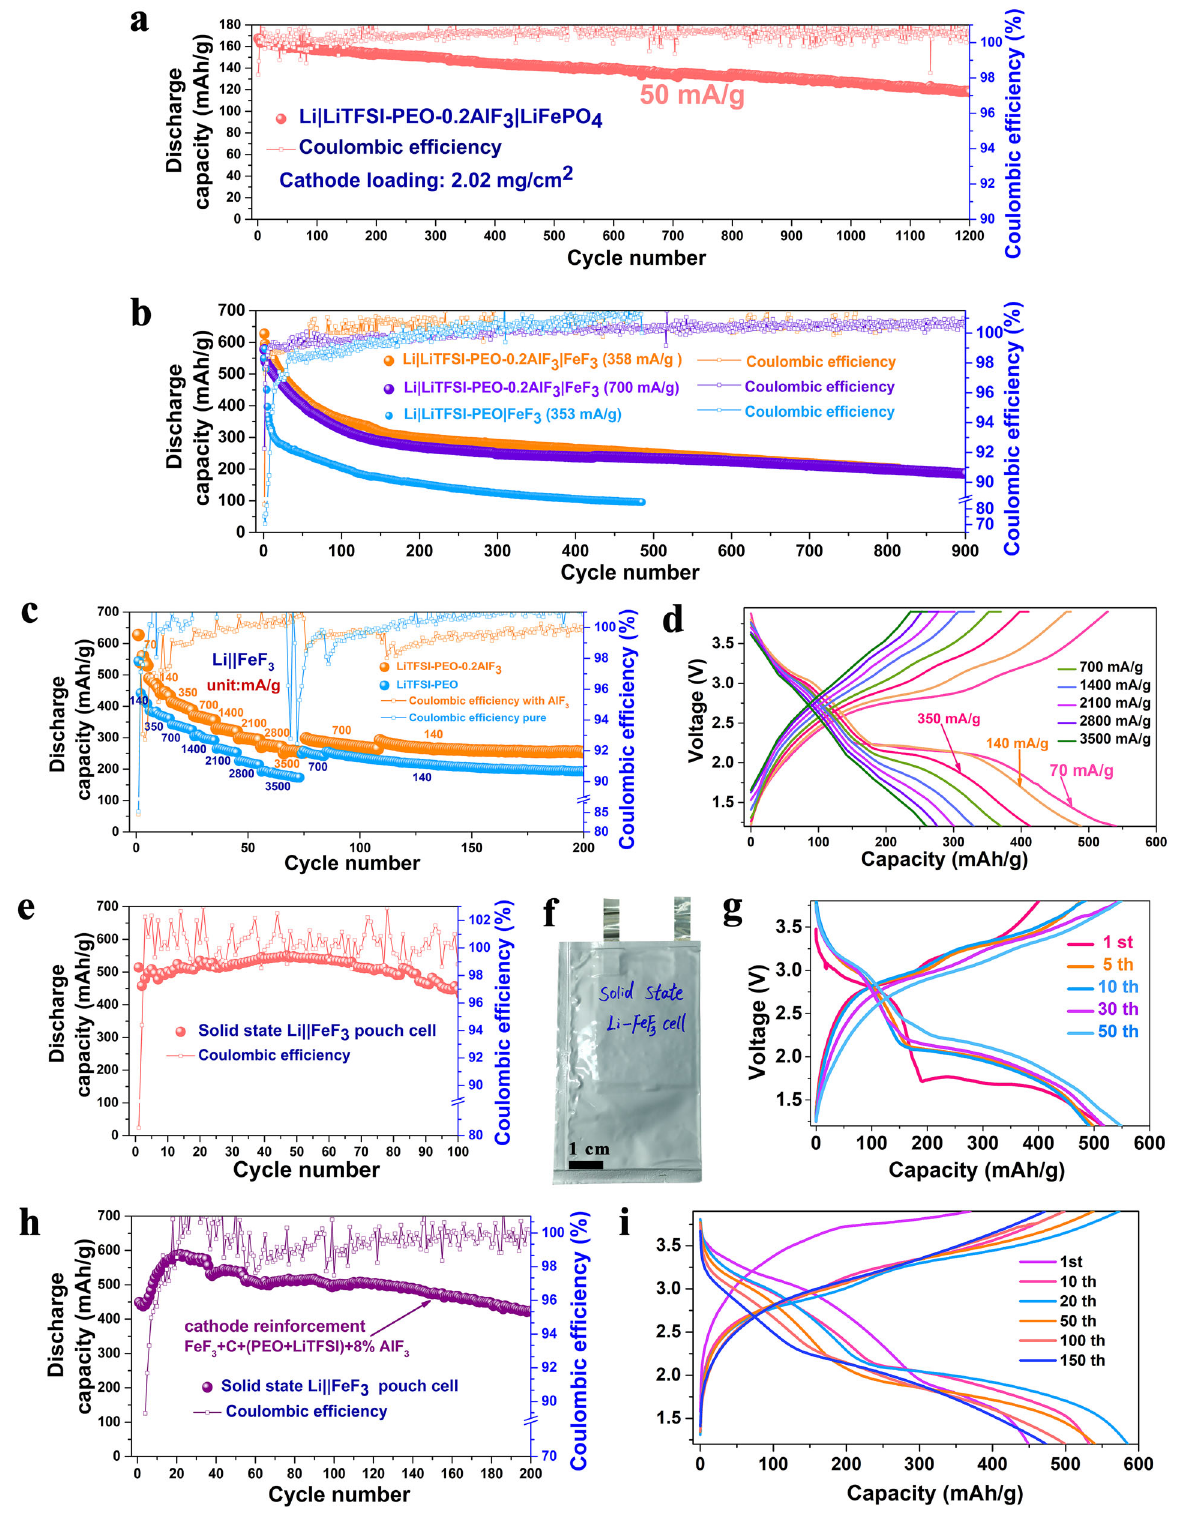
Fig. 6 | Electrochemical performance of solid-state Li||FeF 3 cells. a Cycling performance of Li|LiTFSI-PEO-0.2AlF 3 |LiFePO 4 with a cathode loading of 2.02mg/ cm 2 at50mA/g. b CyclingperformanceofLi|LiTFSI-PEO-0.2AlF 3 |FeF 3 andLi|LiTFSI- PEO|FeF 3 cells at 358 and 700mA/g. c Rate performance of Li|LiTFSI-PEO-0.2AlF 3 | FeF 3 and Li|LiTFSI-PEO|FeF 3 cells. d Corresponding charge and discharge pro fi les of Li|LiTFSI-PEO-0.2AlF 3 |FeF 3 cell at different rates. e Cycling performance of pouch-type all-solid-state Li||FeF 3 cell based on LiTFSI-PEO-0.2AlF 3 electrolyte at a speci fi c current of 110mA/g. f Photo of pouch-type Li||FeF 3 cell. g Corresponding